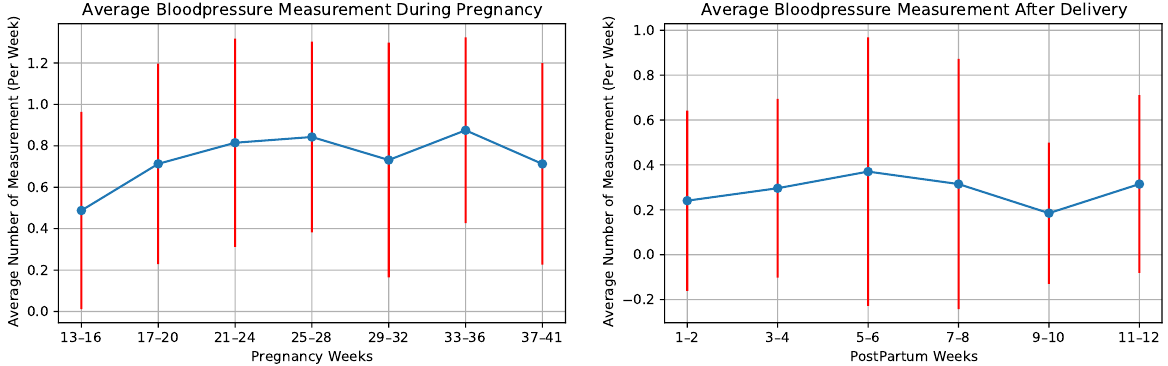
Figure 8. Weekly average number of measuring blood pressure of the 28 high-risk pregnant women during pregnancy and